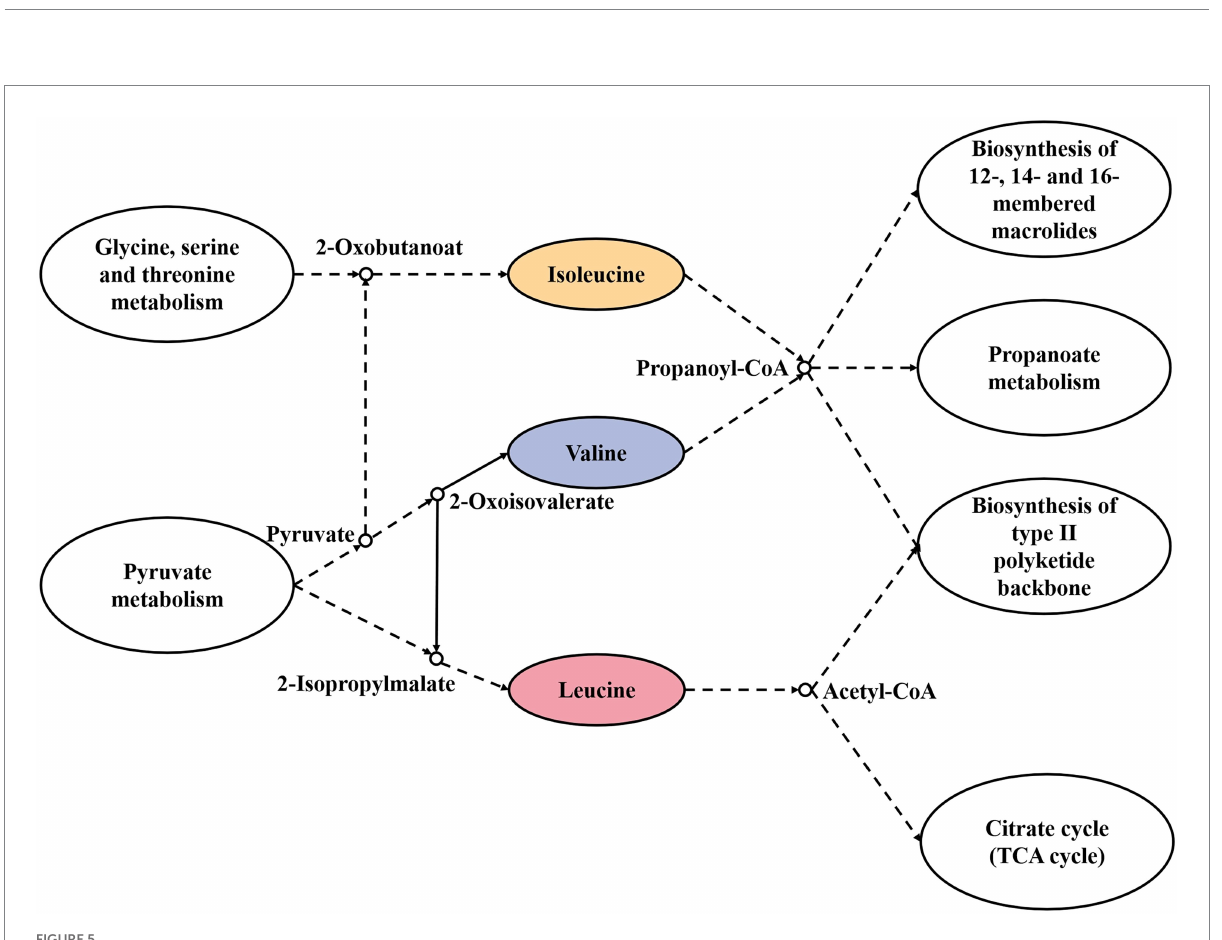
FIGURE 5 Synthesis and metabolic pathway of branched-chain amino